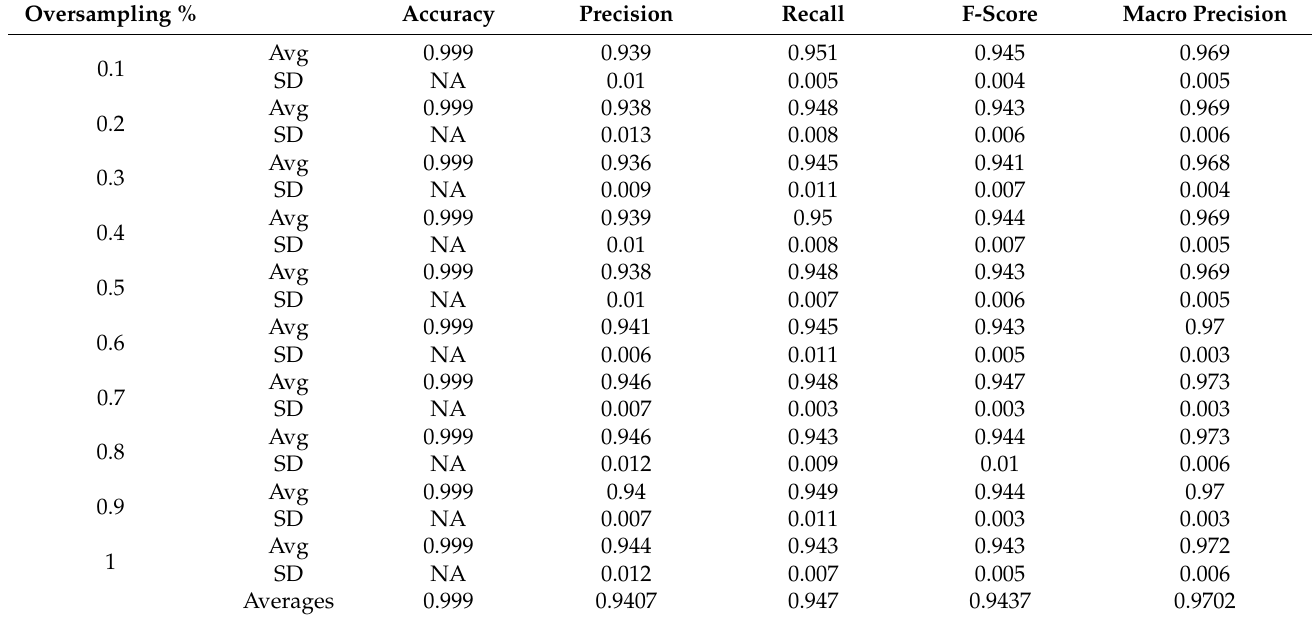
Table 19. UNSW-NB15: Backdoors—classification results for random undersampling after splitting.